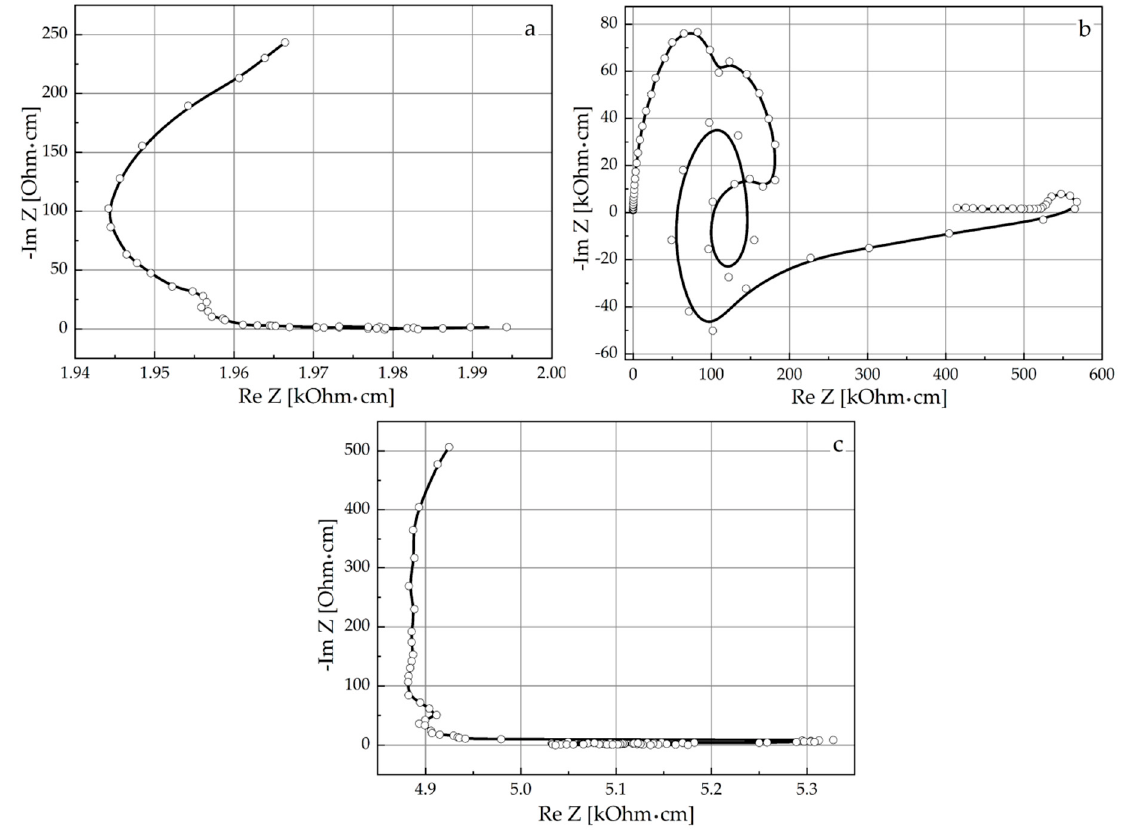
Figure 13. Nyquist plots for the synthesised hybrid structures GaSe(SC(NH 2 ) 2 ) ( a ), GaSe(SmCl 3 ) ( b ) and GaSe(SC(NH 2 ) 2 (SmCl 3 )) ( c ) measured perpendicularly to layers under illumination.